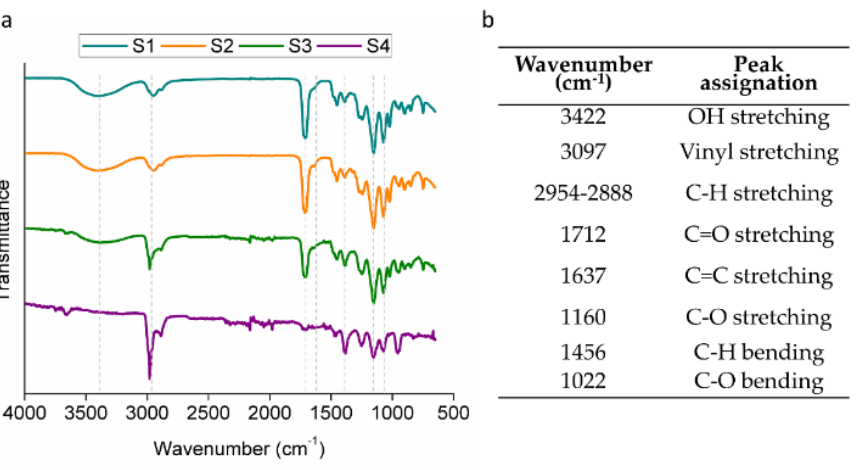
Figure 3. ( a ) Normalized attenuated total reflectance Fourier transformed infrared spectroscopy (ATR-FTIR) spectra of HEMA-based plasma polymer coatings and ( b ) assignation of the main peaks.